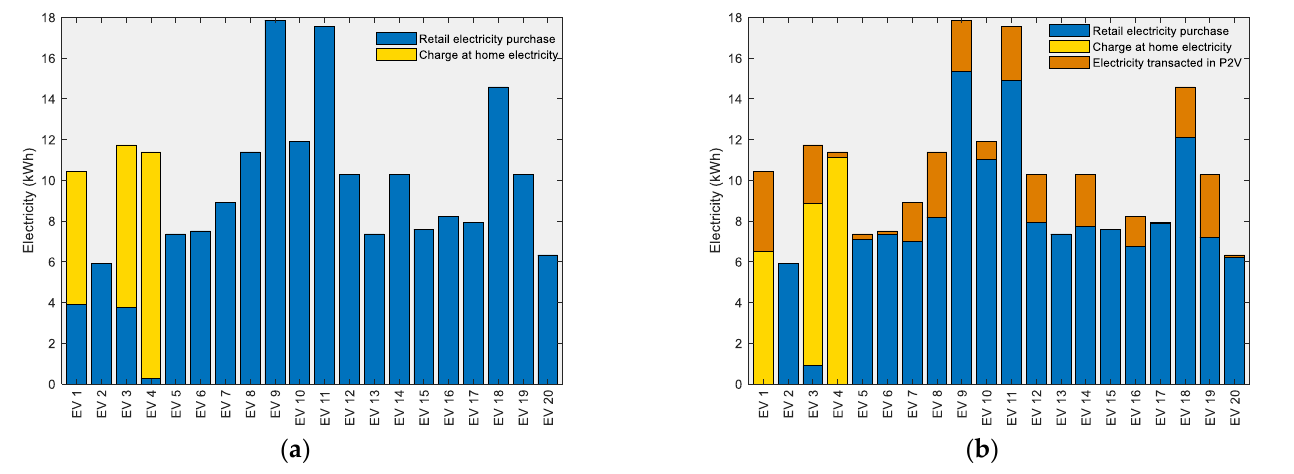
Figure 6. Electricity acquisition by EVs: ( a ) Scenario 1 and ( b ) Scenario 2.